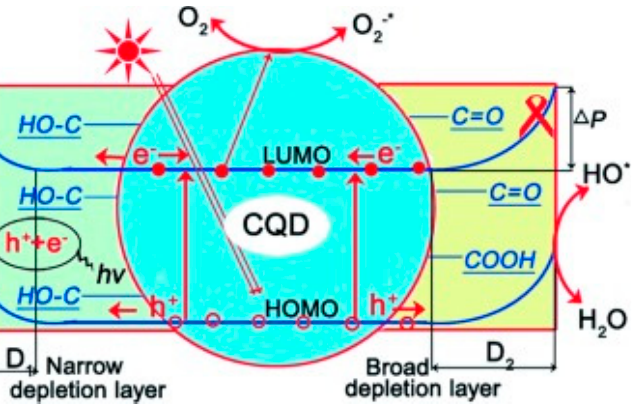
Figure 6. The effects of sizes and surface states of CQDs on the photoluminescent behavior and photocatalytic activities (reprinted with permission from [107], 2013, John Wiley and Sons).